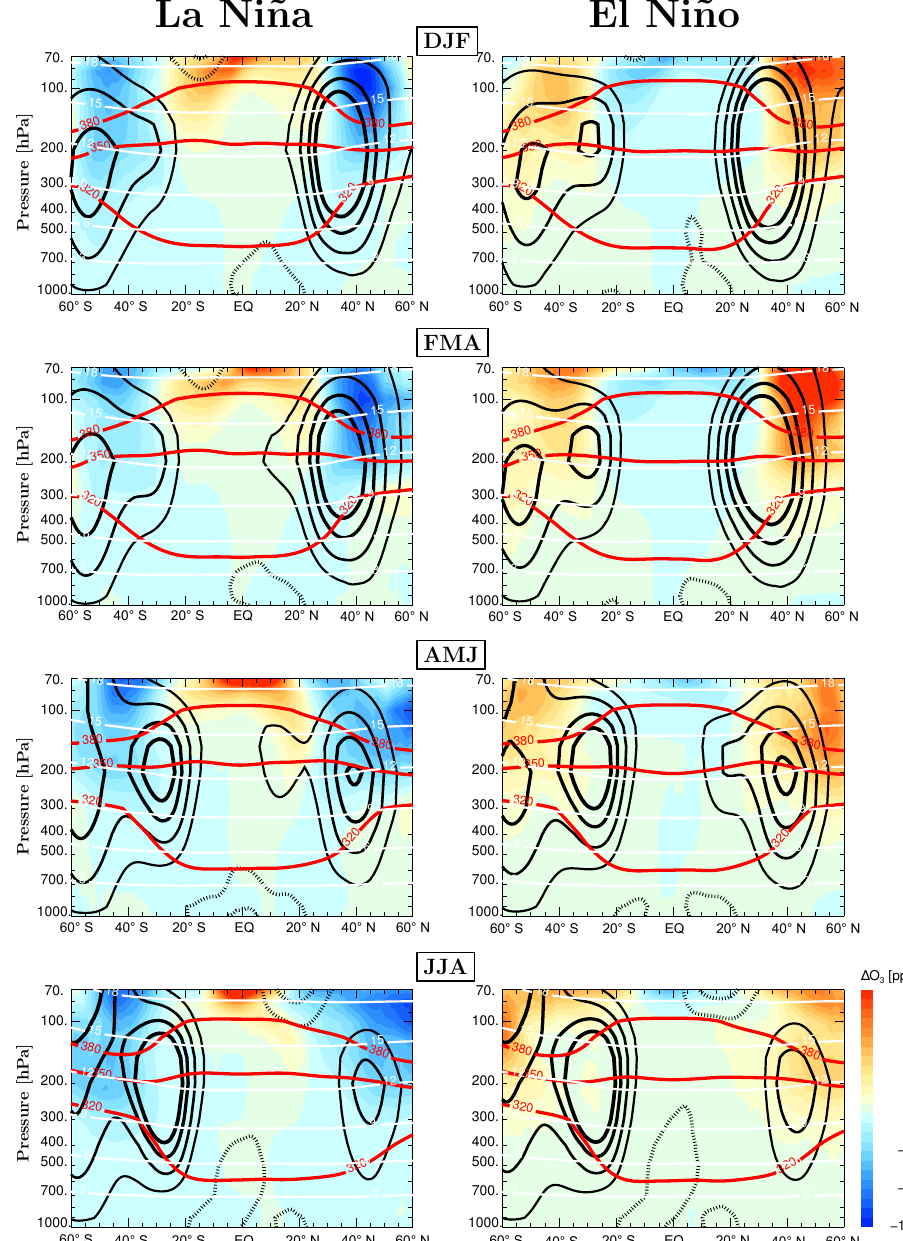
Figure 12. The anomalies of zonally averaged ozone in the western and central Pacific (120 ◦ E, 120 ◦ W) from DJF to JJA based on CLaMS simulations covering 1979–2015. The solid and dashed lines are the zonal means of the westerlies (10, 17, 24 and 30ms − 1 ) and easterlies ( − 5, − 10 and − 20ms − 1 ). Red and white lines represent potential temperature (K) and geopotential height